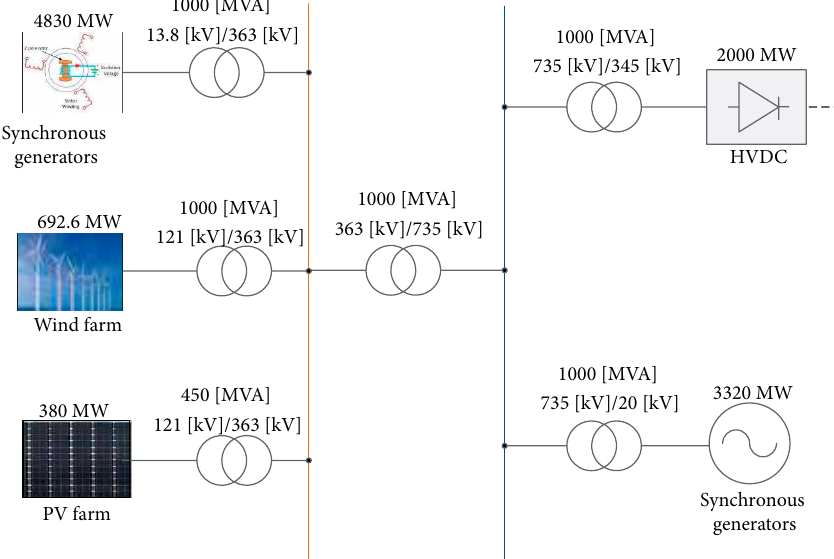
Figure 2: The structure of the power grid to study SSR, its effect,